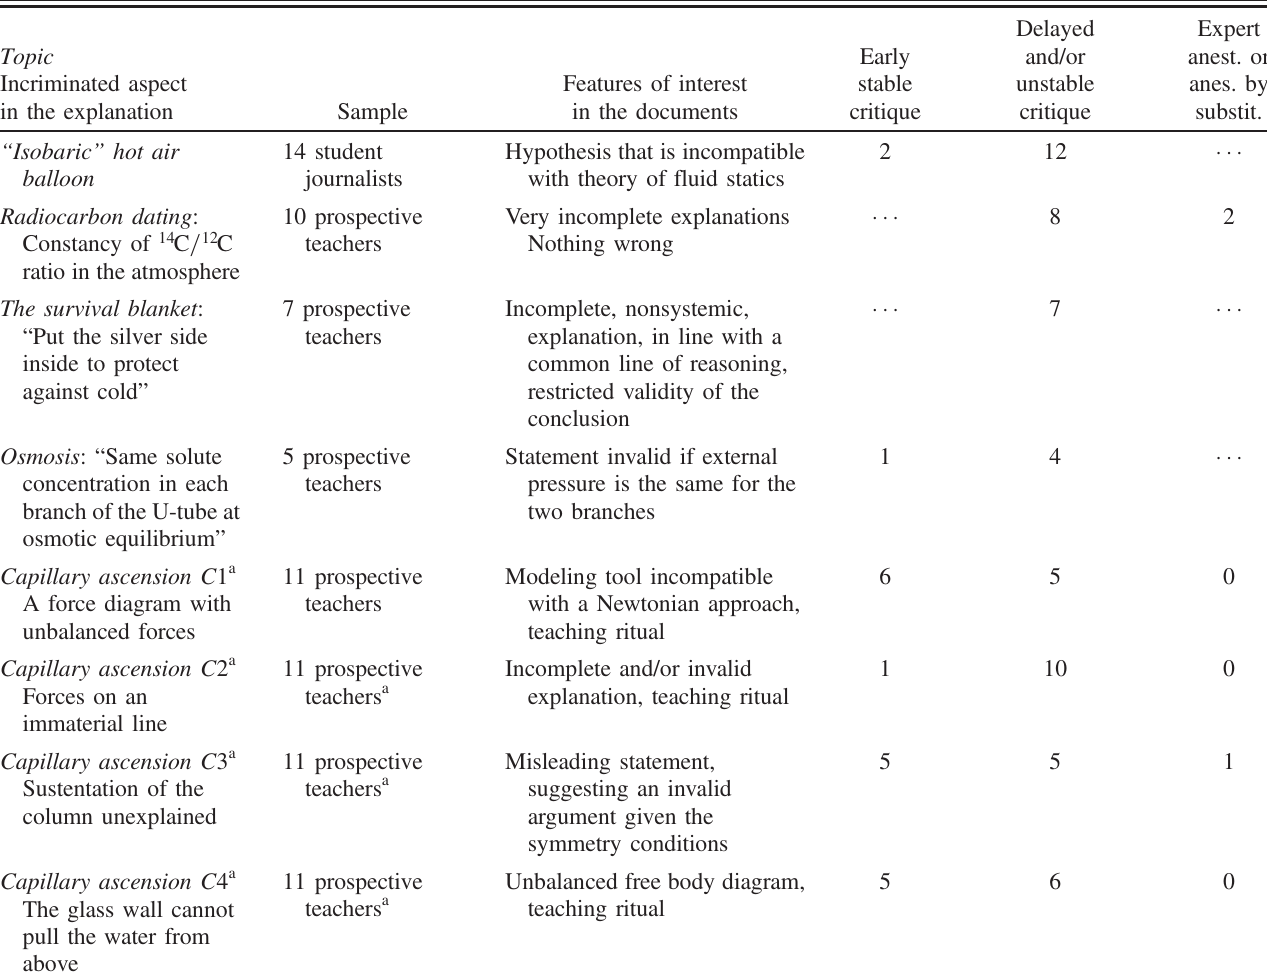
TABLE III. Occurrences of various intellectual dynamics according to the topic and possible critical argument